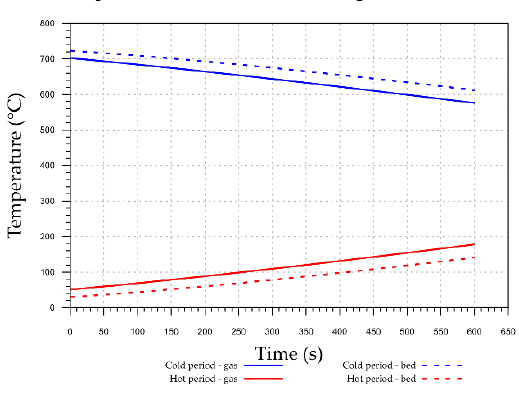
Figure 7. Dependences of temperatures on the time.